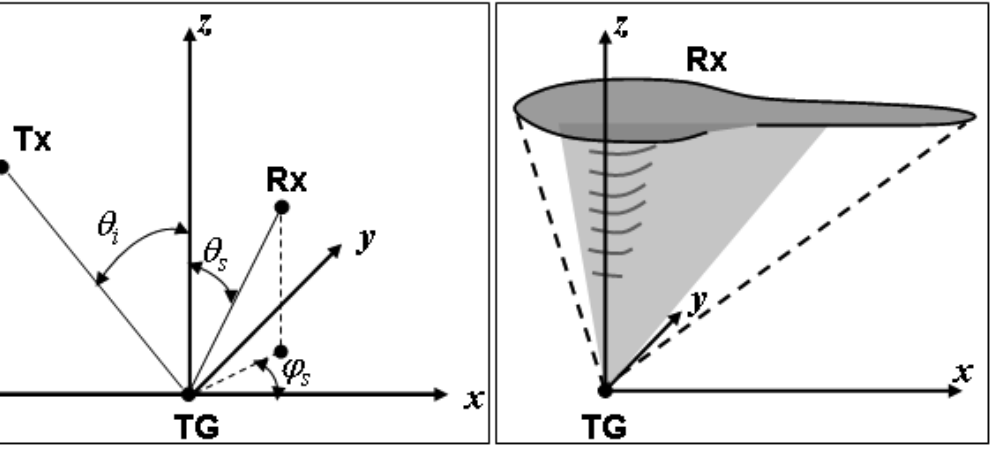
Figure 1. Left panel: geometric elements that identify the transmitter-target-receiver (Tx-TG-Rx) bistatic configuration. Right panel: sketch of observing configurations suitable for SMC